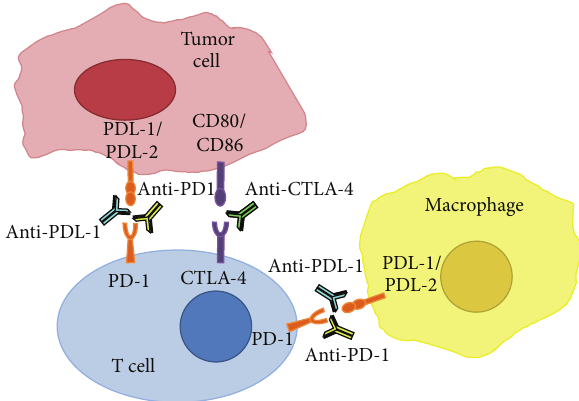
Figure 2: Anti-checkpoint antibodies and their targets.